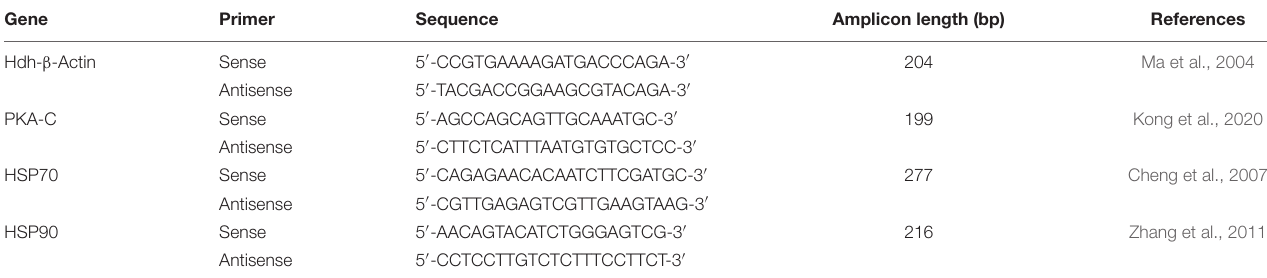
TABLE 1 | List of primers used for qRT-PCR quantification of gene in